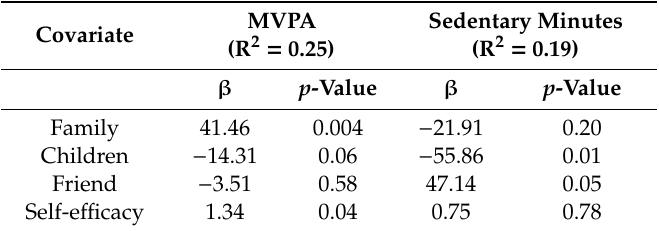
Table 4. Multiple regression analysis results for sedentary activity and MVPA per